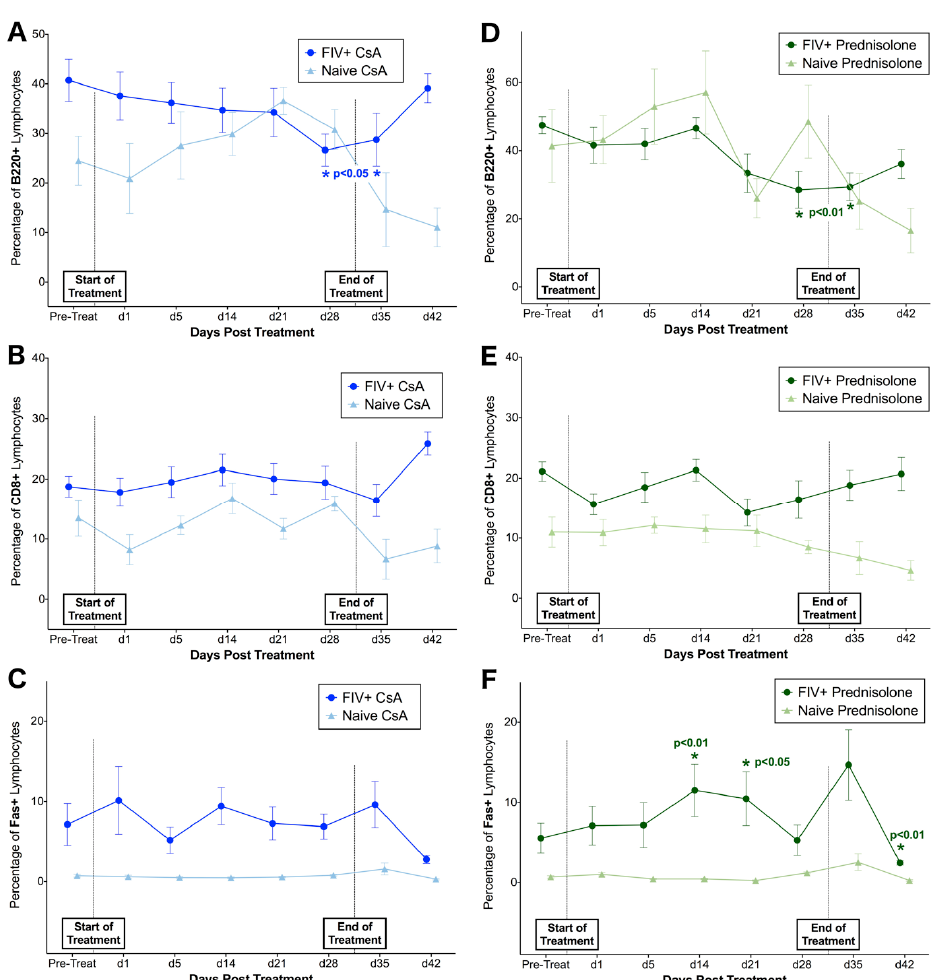
Figure 5. B220 + lymphocytes decrease over time in FIV-infected cats treated with CsA and